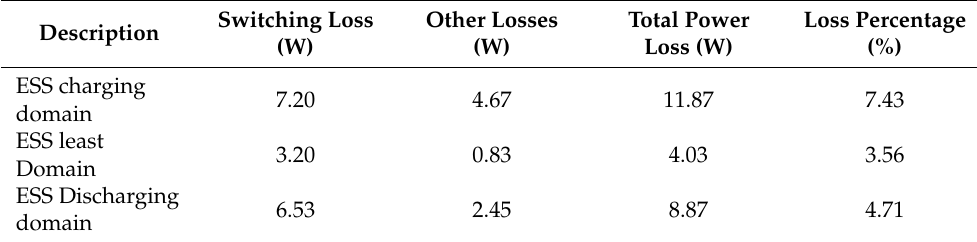
Table 3. Power Loss Comparison in all the Domains.